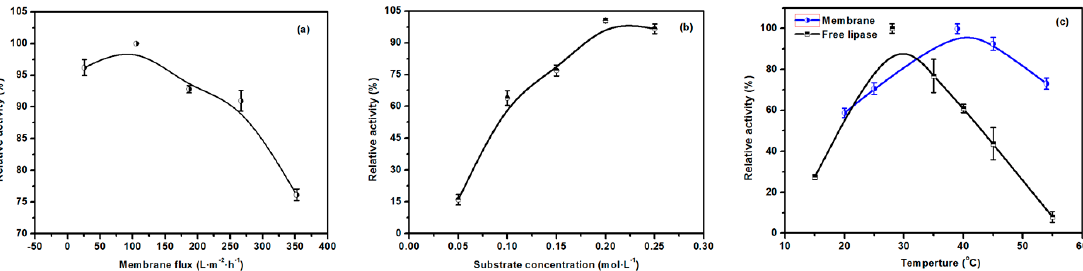
Figure 9. Effect of membrane flux ( a ); substrate concentration ( b ); and temperature ( c ) on the activity of the free and immobilized lipase.